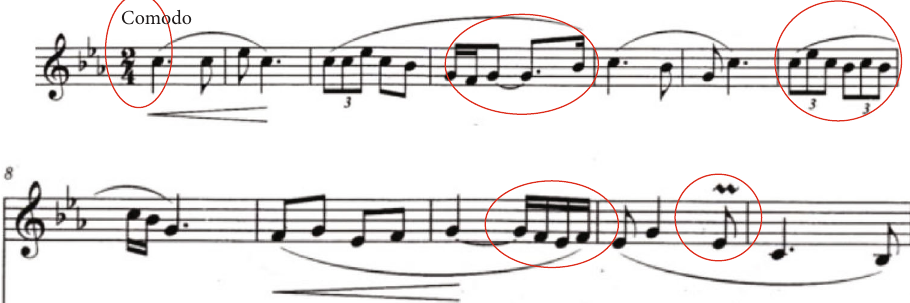
Figure 5: Schematic diagram of expression changes in music reading music.